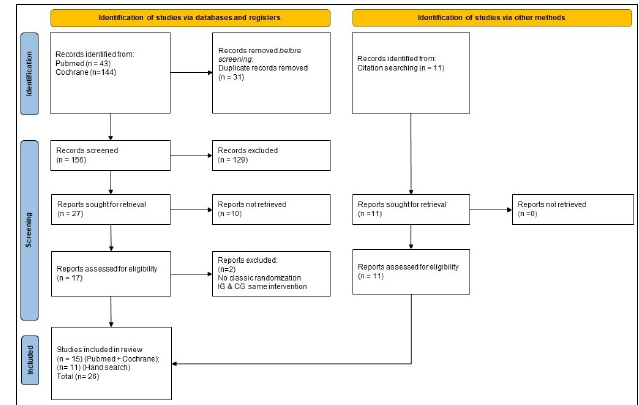
Figure 1. Prisma flow diagram .